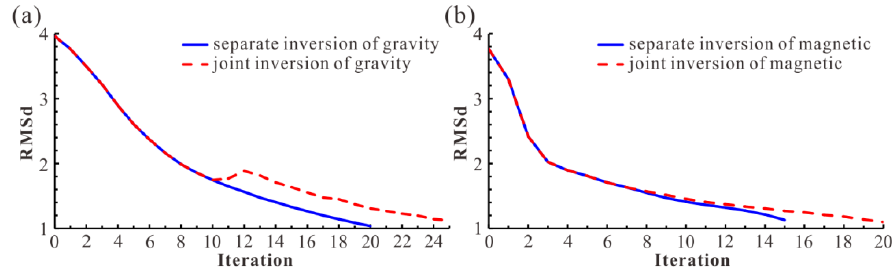
Figure 21. RMSd of inversion. ( a ) RMSd of gravity; ( b ) RMSd of magnetic.